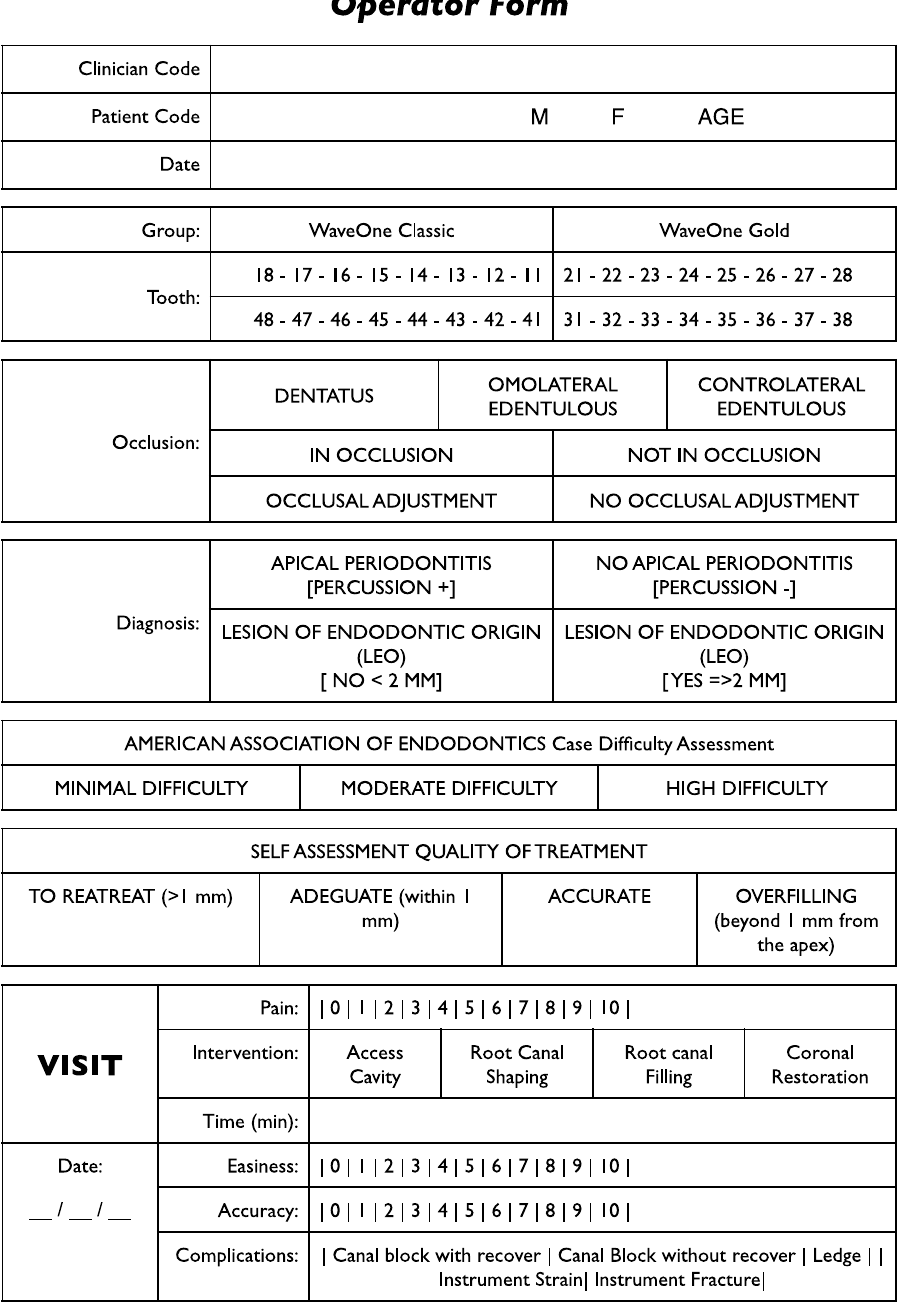
Figure A3. Operator